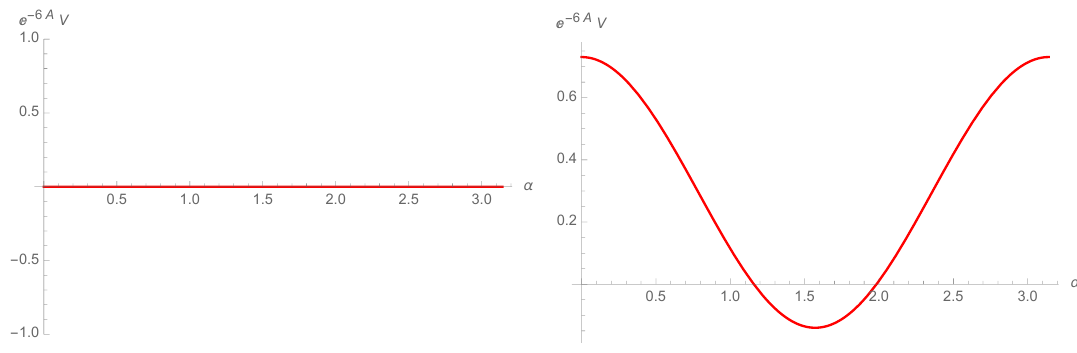
Figure 2 . The probe brane potentials of the supersymmetric and non-supersymmetric (cid:12)xed points at X = 1 and X = 1 = 2 1 = 5 ,